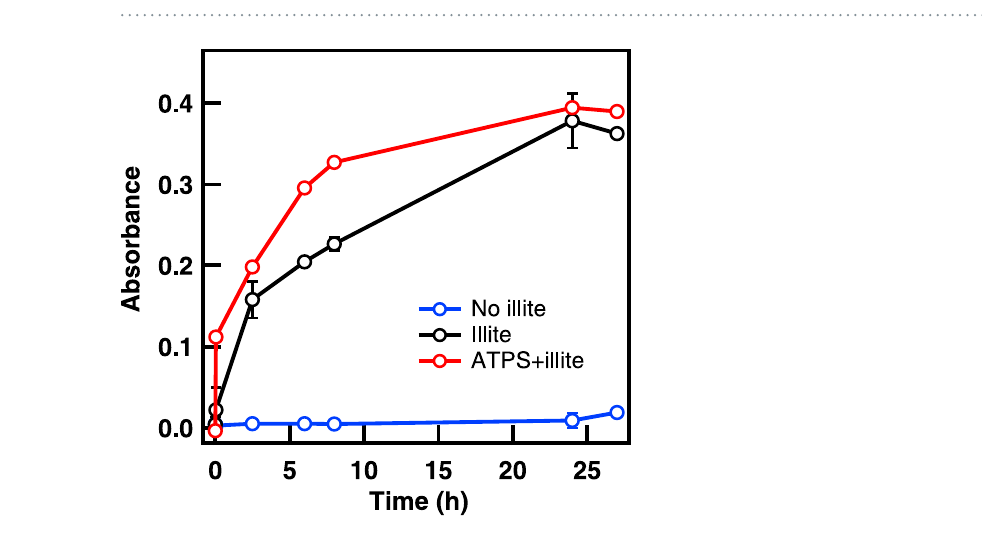
Figure 8. OPD reaction progress. Reaction product absorbance at 417 nm in buffer with substrates without presence of illite (blue), in buffer with illite and substrates (black) and in 20:1 ratio of Dx-rich phase/PEG-rich phase with substrates (red). Hydrogen peroxide was held in excess at 8.8 mM and OPD was 500 µ M in 100 mM HEPES buffer, pH 7.5. Error bars represent the standard deviation of the